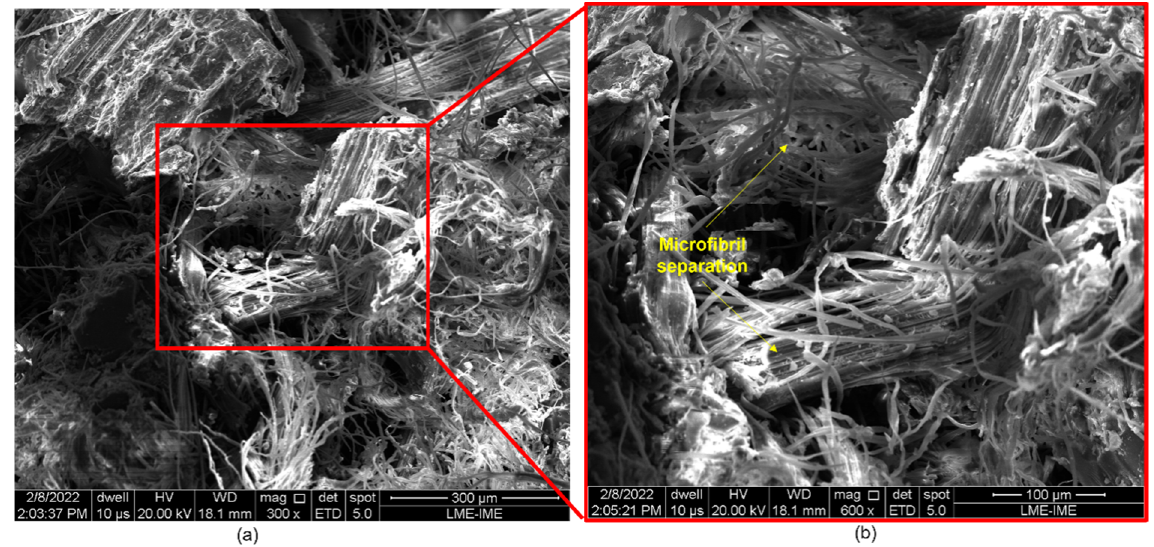
Figure 11. Fracture surface of a bidirectional composite with 30 vol.% fibers (PGO/ENT) at 300× ( a ) and 600× ( b ) magnifications.